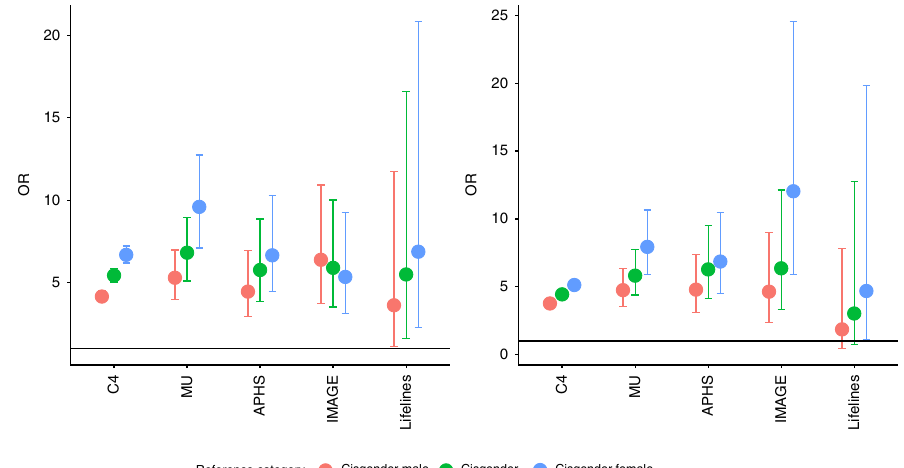
Fig. 2 ORs and 95% CIs for autism in transgender and gender-diverse individuals compared to cisgender males, cisgender females, and cisgender individuals altogether. a This fi gure provides the unadjusted Odds Ratios (ORs, point) and 95% CIs for autism in transgender and gender-diverse individuals compared to either cisgender males, cisgender females, or cisgender (cisgender males and cisgender females) individuals in fi ve datasets (C4: N = 514,100; MU: N = 85,670; APHS: N = 2312; IMAGE: N = 1803; and LifeLines: N = 37,975). b This fi gure provides adjusted ORs (point) and 95% CIs for autism in transgender and gender-diverse individuals compared to cisgender males, cisgender females, or all cisgender individuals in fi ve datasets (C4: N = 514,100; MU: N = 85,670; APHS: N = 2312; IMAGE: N = 1803; and LifeLines: N = 37,975). ORs have been adjusted for age, educational attainment, and in the case of IMAGE dataset, an additional dummy variable for study (see “ Supplementary Methods ” ). The y -axis is on the same scale for both the panels. The differences in ORs for the IMAGE dataset between Models 1 and 2 is primarily due to the inclusion of “ study ” group as a covariate. Speci fi cally, the IMAGE dataset consists of individuals recruited into a study of mathematics and autism ( “ Methods ” ). Whilst the mathematics group is predominantly male and have higher educational attainment (all have at least an undergraduate degree), the case – control group had a more balanced ratio and a wider range of educational attainment. Covarying for the study the participants have been recruited into (mathematics or autism case – control) changes the